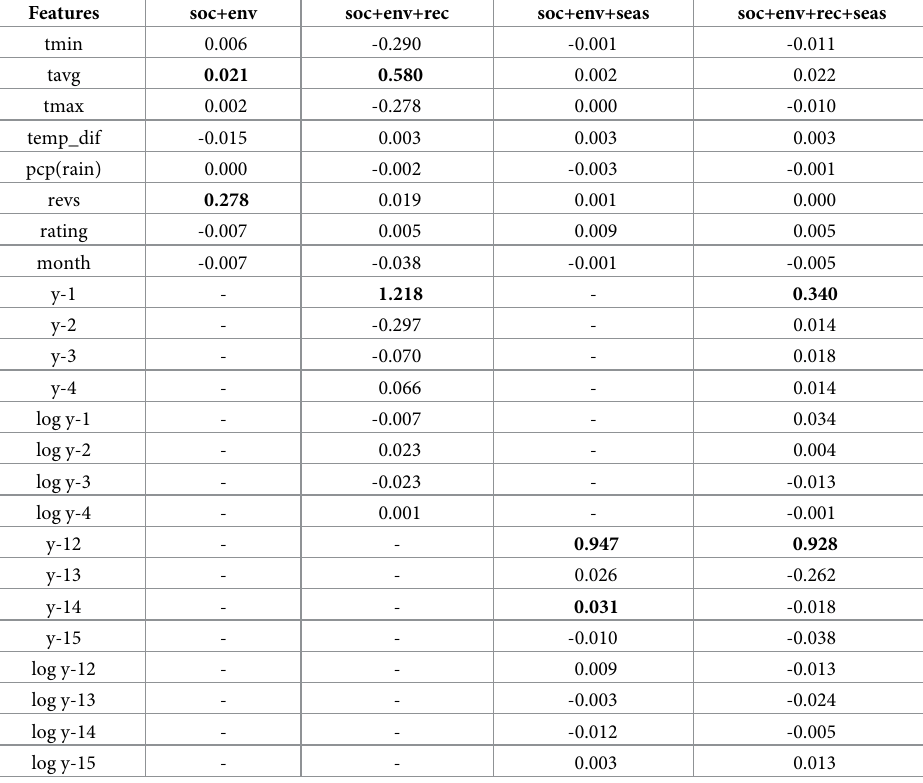
Table 10. The coefficients of features of global (single) model for all 76 U.S. National Parks adopting each time a different set of features: (I) only social media and environmental features (soc+env), (II) social media, environ- mental and recency features (soc+env+rec), (III) social media, environmental and seasonality features (soc+env+- seas), (IV) complete feature set: Social media, environmental, seasonality and recency feature (soc+env+rec+seas). The bold face shows the top 2 features in each